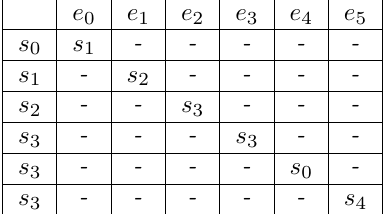
{ s 4 } . Figure 5 tabulates the transition function M j . ∆